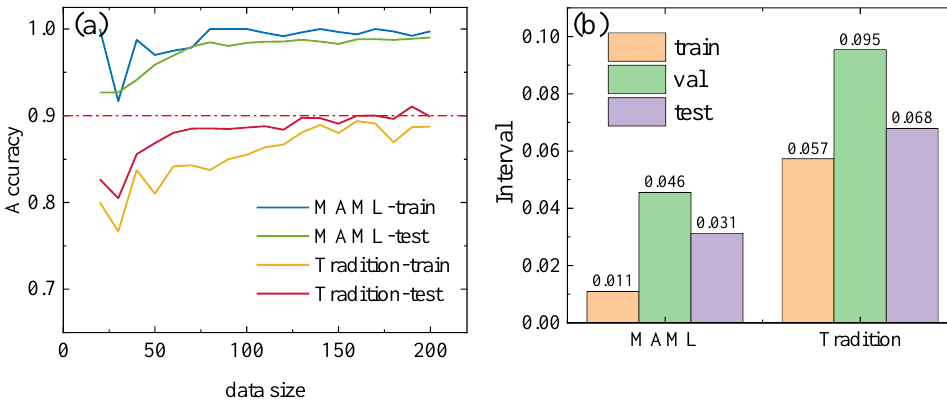
Figure 15. Performance of MAML-ANN and traditional ANN. ( a ) Accuracy for different data sizes; ( b ) average interval of accuracy between normal and abnormal